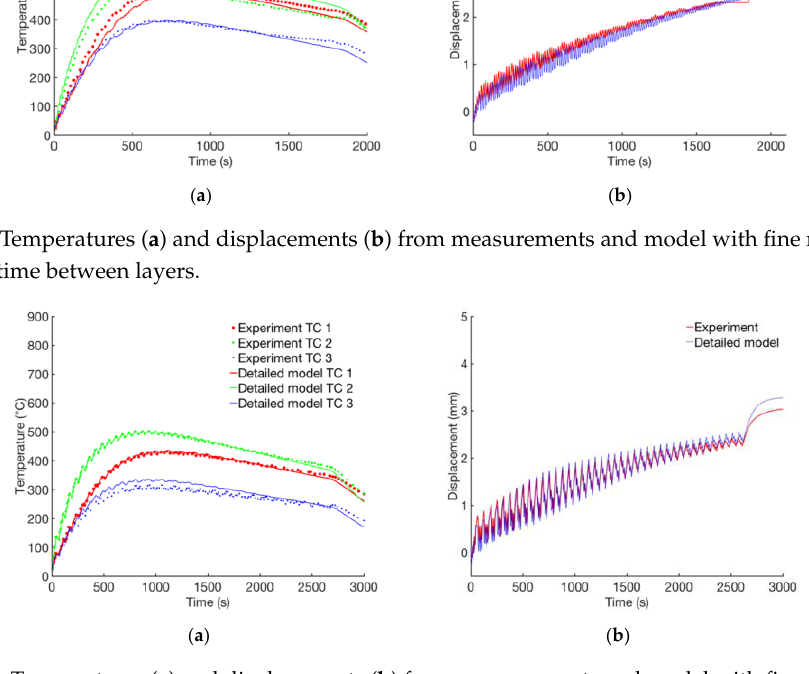
Figure 10. Temperatures ( a ) and displacements ( b ) from measurements and model with fine mesh and 20 s dwell time between layers.